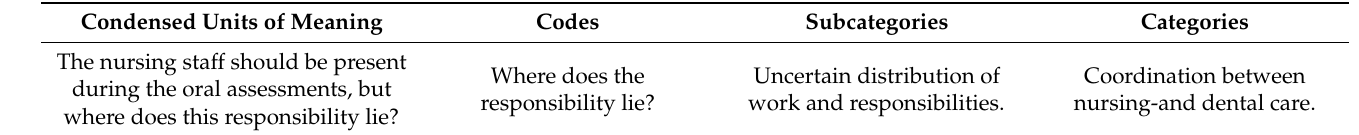
Table 2. An example from the analysis regarding the category “Coordination between nursing and dental care”.